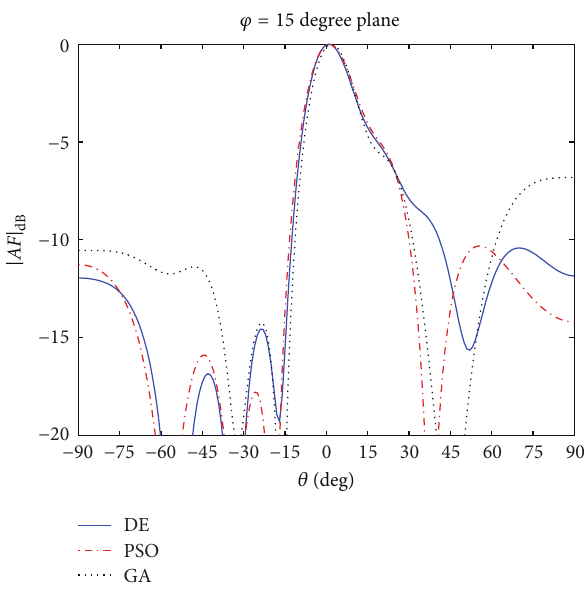
Figure 7: Optimized cosec 2 patterns from the concentric ring array for 𝜑 = 15 degree